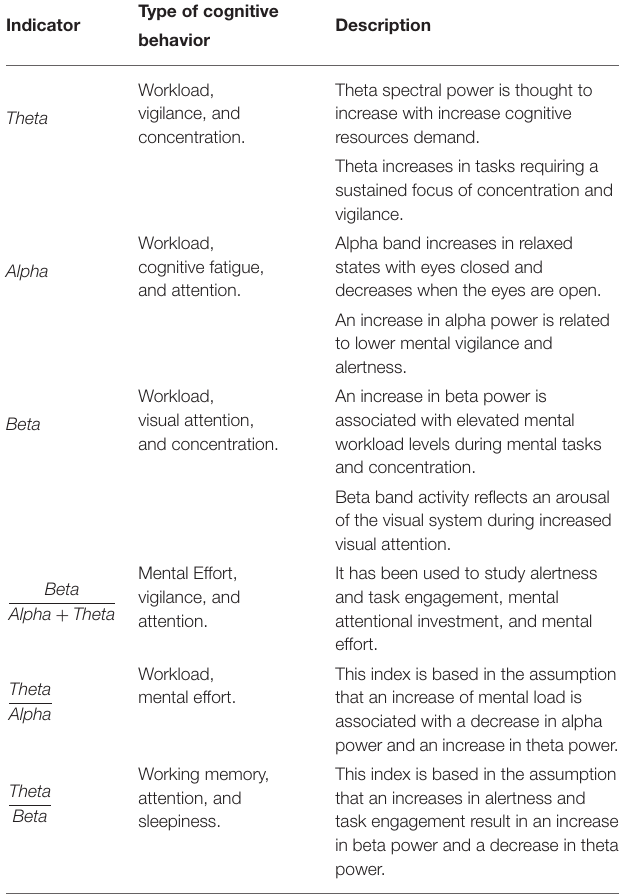
TABLE 1 | Summary of EEG correlates of spectral powers for the assessment of cognitive workload in the literature. Type of cognitive Indicator